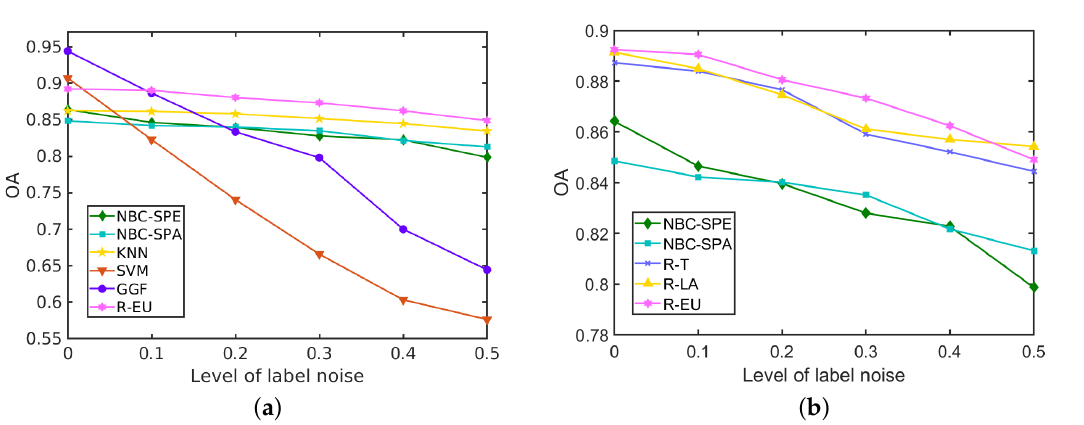
Figure 13. Influence of the label noise on the performance (in terms of OA of different methods) on the HYDICE Urban data set. ( a ) R-EU compared with other methods; ( b ) Comparisons among three strategies.